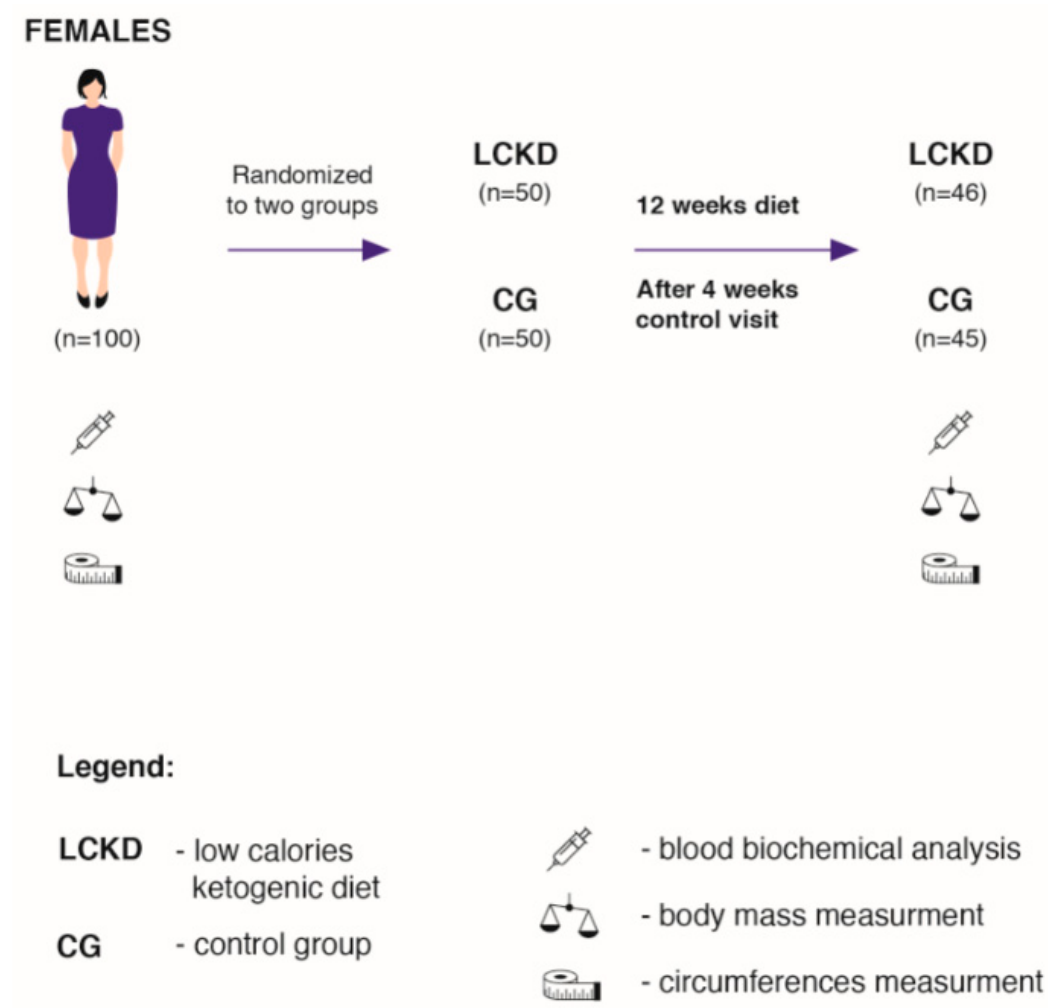
Figure 1. Scheme of the descriptive analysis. LCKD—low calories ketogenic diet; CG—control group.